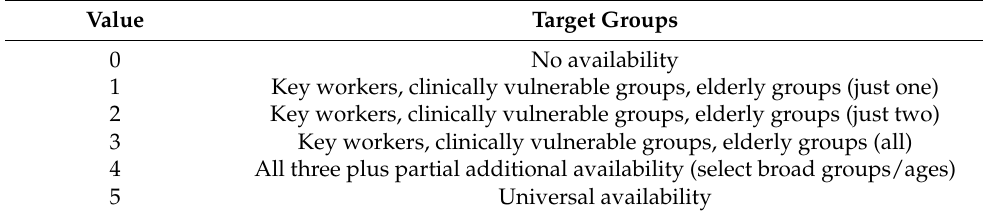
Table 2. Vaccination policy—Oxford COVID-19 Government Response